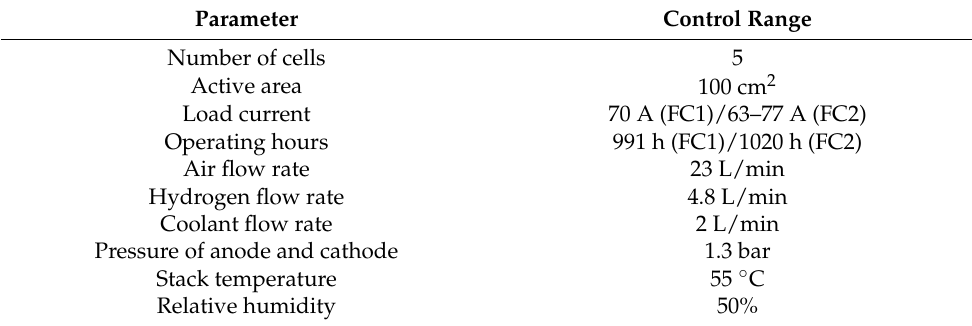
Table 1. PEMFC stack and experimental operating parameters.